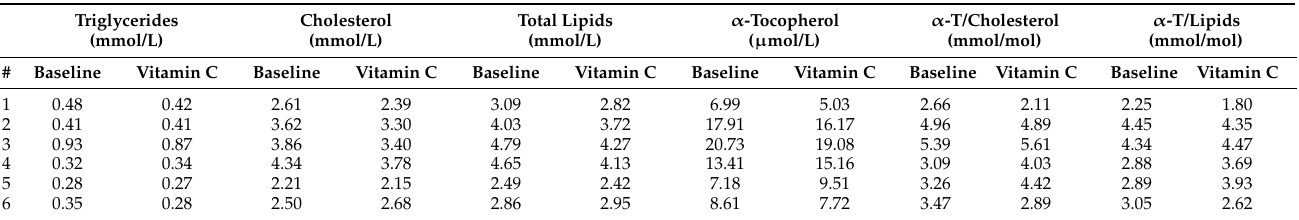
Table 2. The participants’ lipid concentrations during baseline and vitamin C